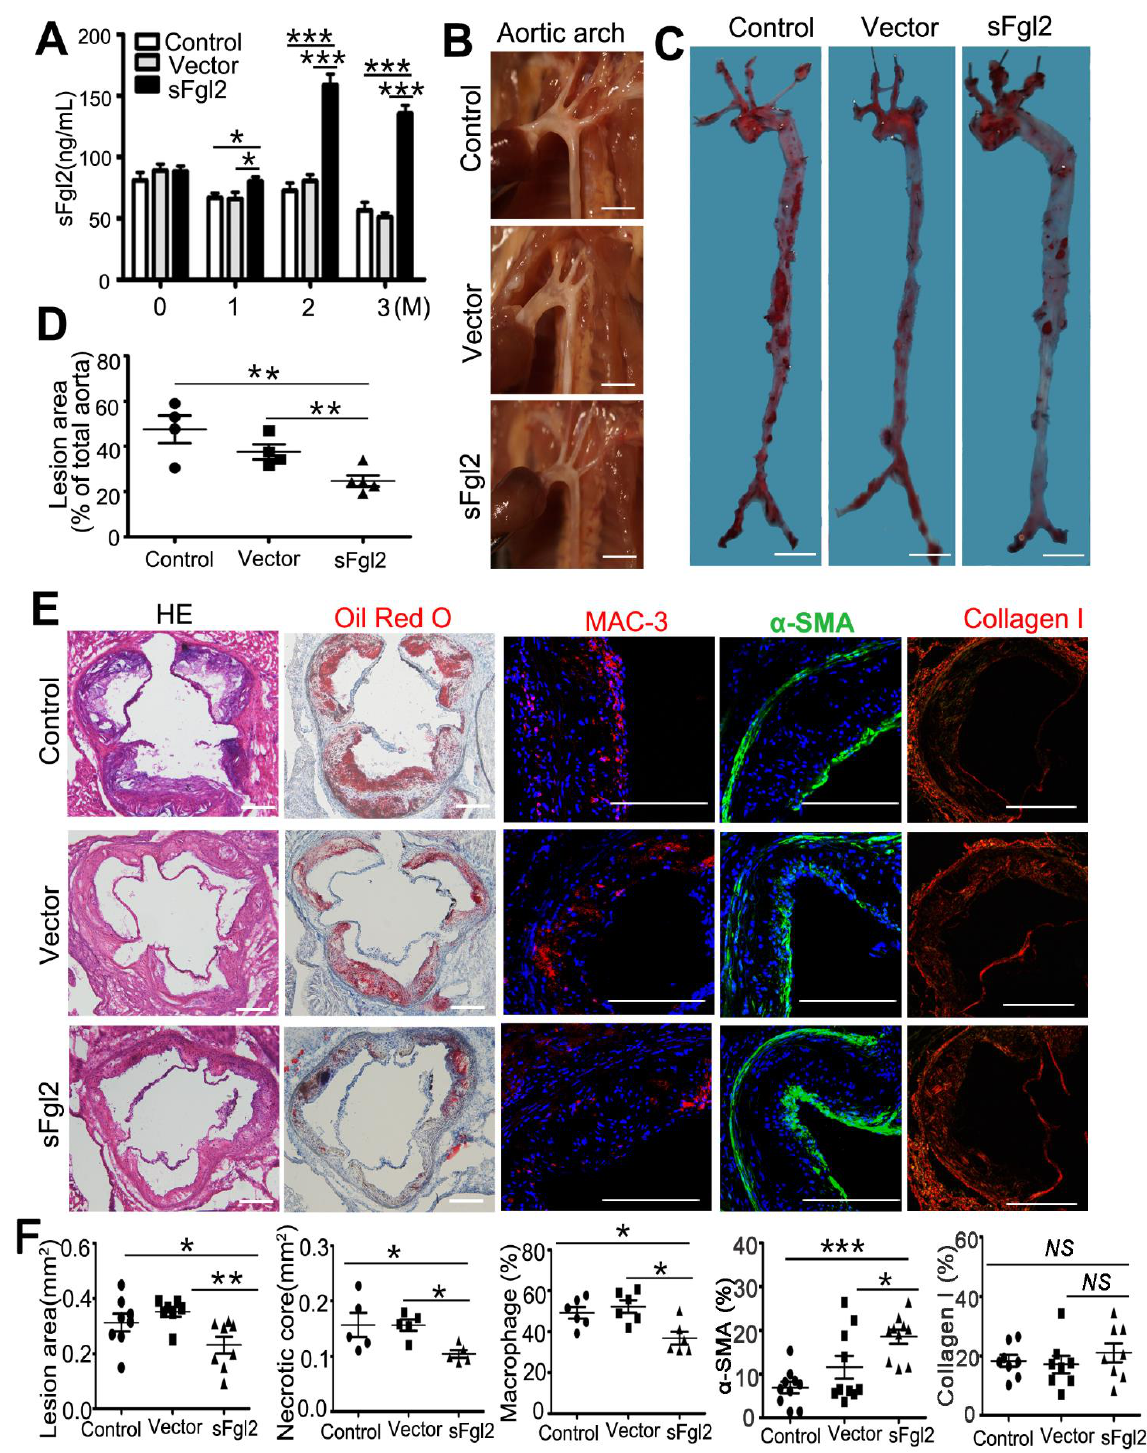
Figure 2. sFgl2-AAV alleviates artery burden and protects against atherosclerosis. (A) The expression levels of sFgl2 in PBS-, Vector-AAV-, and sFgl2-AAV- tail-vein-injected ApoE -/- mice were detected by Elisa after feeding Western diet for 0, 1, 2, and 3 M. (B) Aortic arch lesion area in the three groups. Scale bar = 2 mm. (C) Oil Red O staining of the aorta en face lesion area. Scale bar = 500μm. (D) Quantification of relative lesions area of the aorta. (E) Representative photomicrographs and (F) quantifications result of HE, Oil Red O, MAC- 3, α -SMA, and collagen I. Scale bar = 200μm. NS = Not significant, * p < 0.05, ** p < 0.01, *** p < 0.001. Data were represented as mean ± SEM.